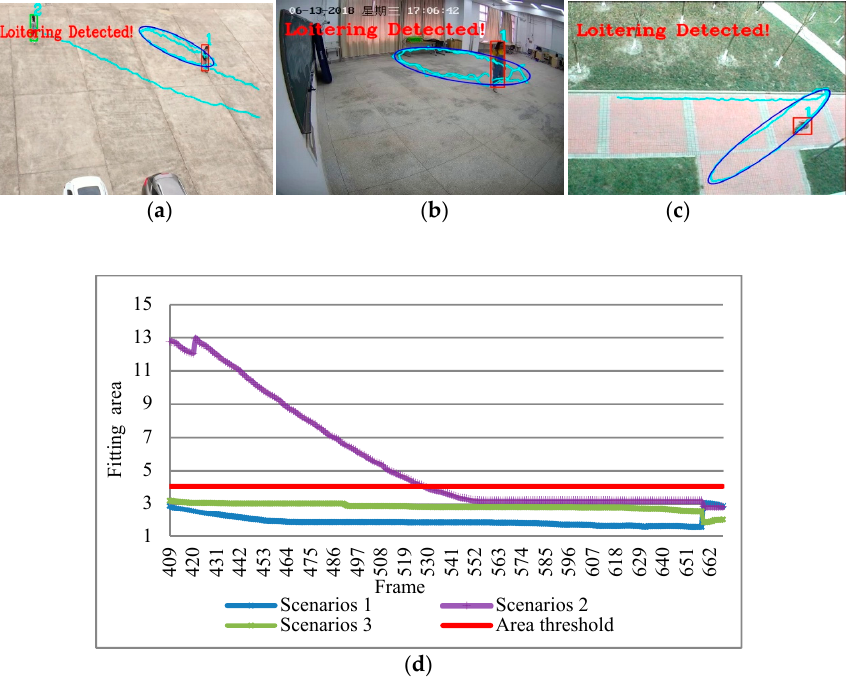
Figure 14. The result of ellipse loitering. ( a – c ) The activity area fitting process from scenarios 1 to 2. ( d ) The area fitting curve results of ellipse loitering, the red line in the figure indicates the threshold of the area.